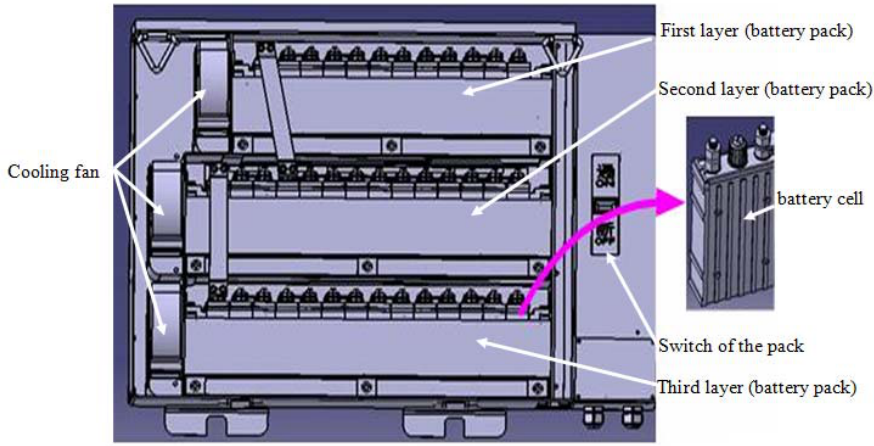
Figure 3. Configuration of the primitive HEV NiMH battery pack: 36 cells (3 rows and 12 columns) in the first (top) layer; 42 cells (3 rows and 14 columns) in each of the other layers.